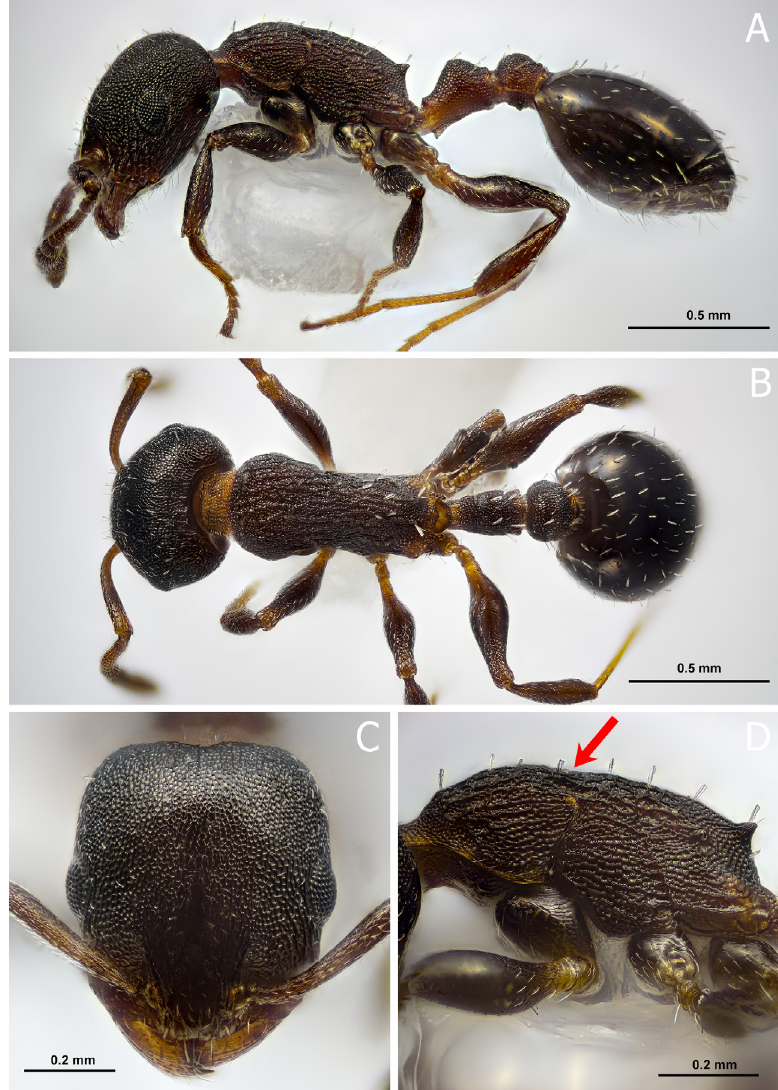
Fig 3 . Worker of T. convexus . A: lateral view. B: dorsal view. C: frontal view. D: detail of mesosoma, with the distinct short pilosity and pronounced promesotonal furrow (red